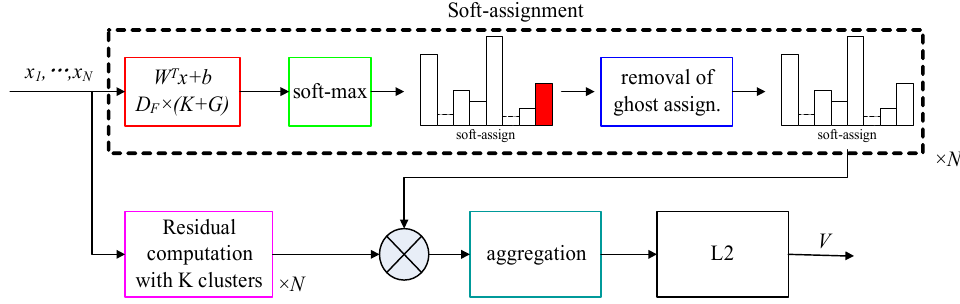
Figure 2. The structure of ResNet ‐ 50.